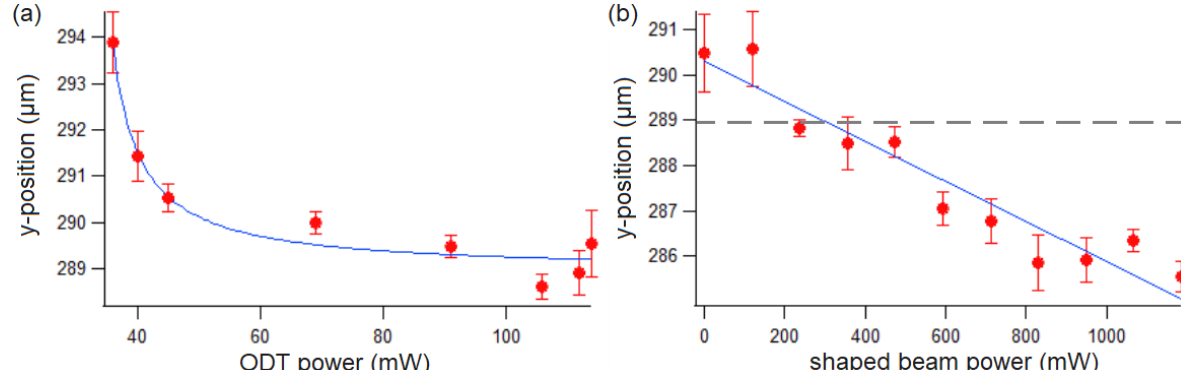
Figure 3. Optimization procedure for gravity compensation with a shaped optical beam. ( a ) measured BEC position with absorption imaging, as the ODT depth is increased. The converging locations at higher depths indicate a reduction of the displacement due to the gravitational potential. The blue curve is a best-fit reciprocal function; ( b ) introduction of the linear optical potential at low ODT depth. The BEC position has a nearly linear dependence on the shaped beam power as the net background potential gradient changes. The dashed line marks the asymptotic value of the reciprocal function shown in ( a ). The solid blue curve is a best-fit line to this